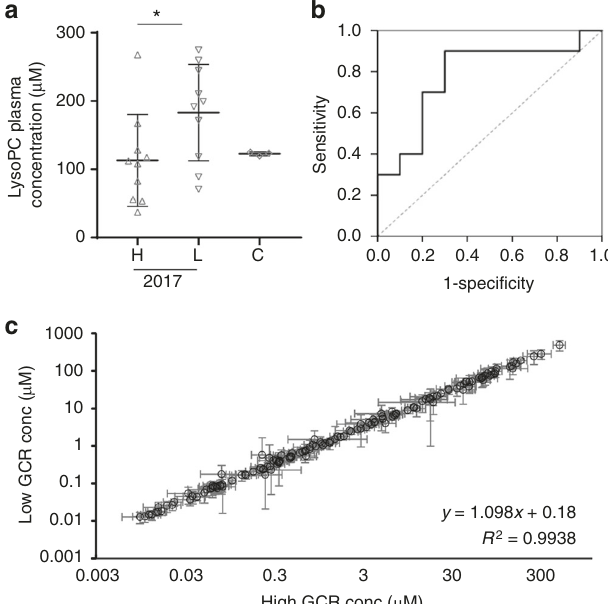
Fig. 3 The association of LysoPC level and gametocyte conversion. a The total concentration of all 13 LysoPC isoforms tested is plotted for each of the samples in the 2017 high (H) ( n = 10) and low (L) ( n = 10) GCR cohorts and control serum from North American volunteers ( n = 3)